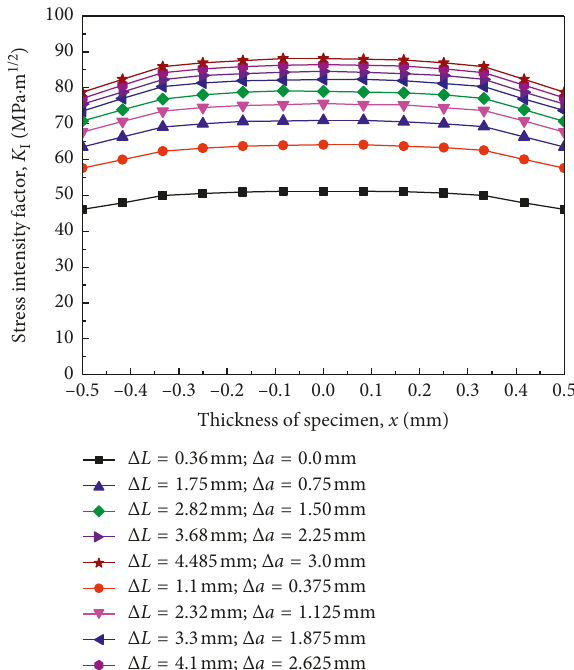
I along the thickness of